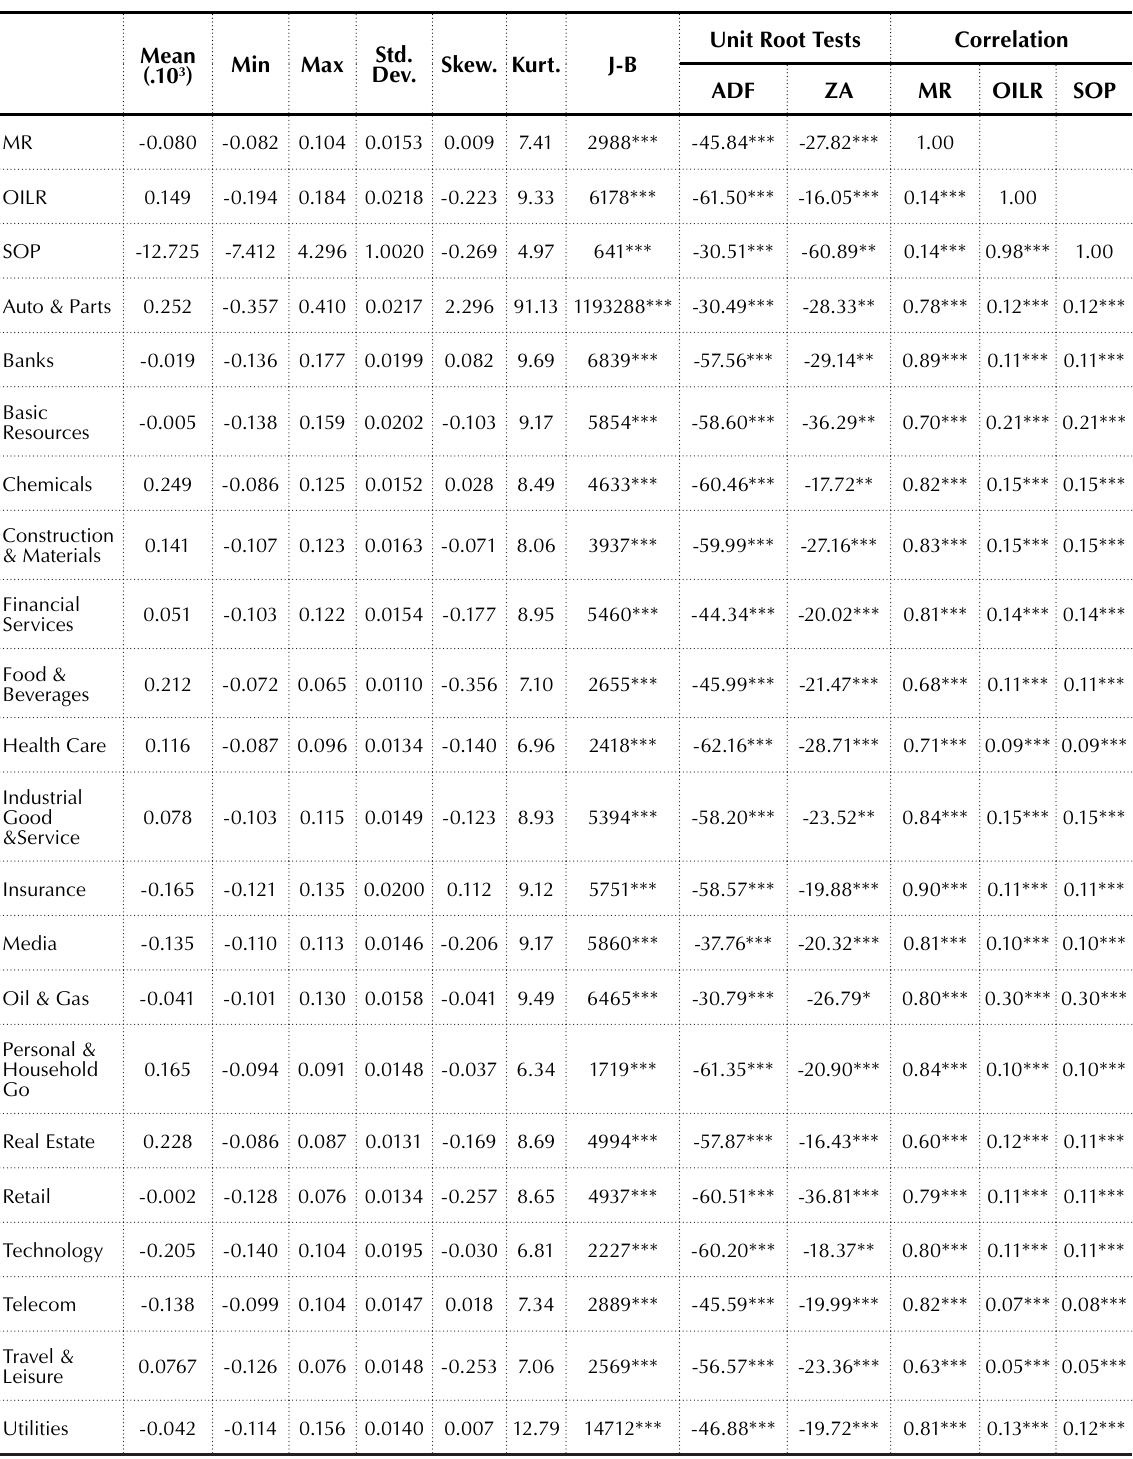
Table 1. Descriptive